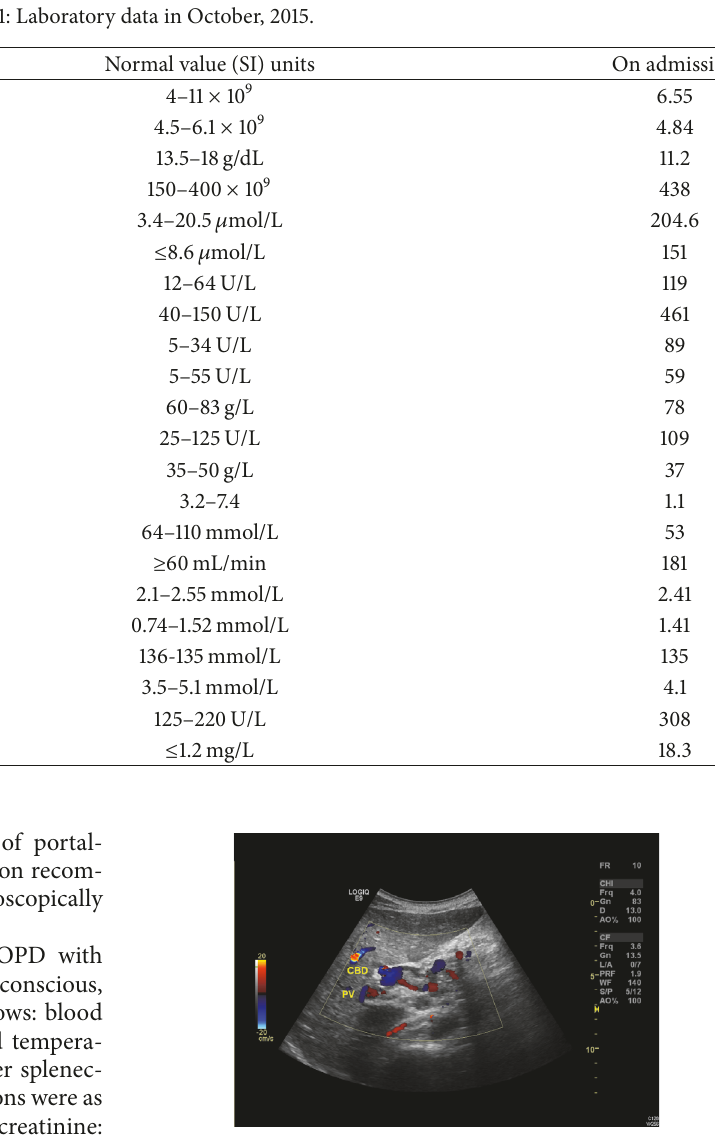
Figure 1: Abdominal ultrasound (post-ERCP with stenting) show- ing multiple intraluminal stones in the gallbladder with thick biliary sludge and diffusely thickened wall. Biliary stent is seen with the visualized portion of distal CBD that also appears slightly dilated at the porta hepatis. Minimal central intrahepatic biliary dilatation is also seen. Status after